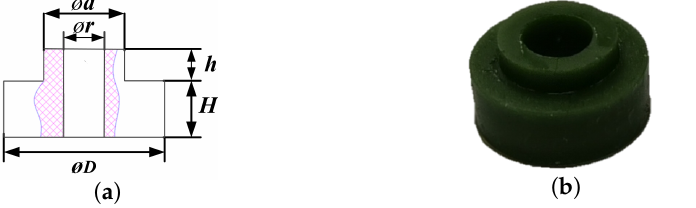
Figure 4. T-shaped rubber isolator. ( a ) Sketch; ( b ) Real production